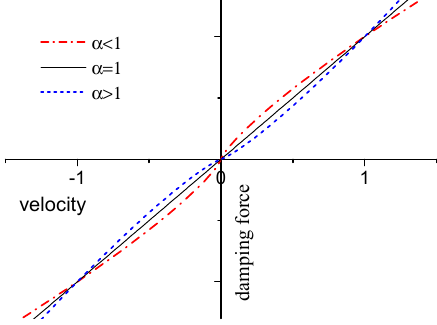
Figure 2. Damping Force and Velocity Curve with different Velocity Indices.